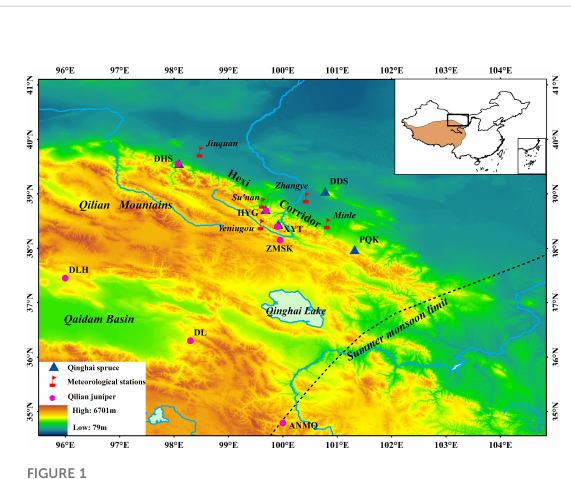
FIGURE 1 Locations of Qinghai spruce sampling sites (triangles), Qilian juniper sampling sites (circles) and meteorological stations ( fl ags). For Qilian juniper site information, refer to Yang et al.